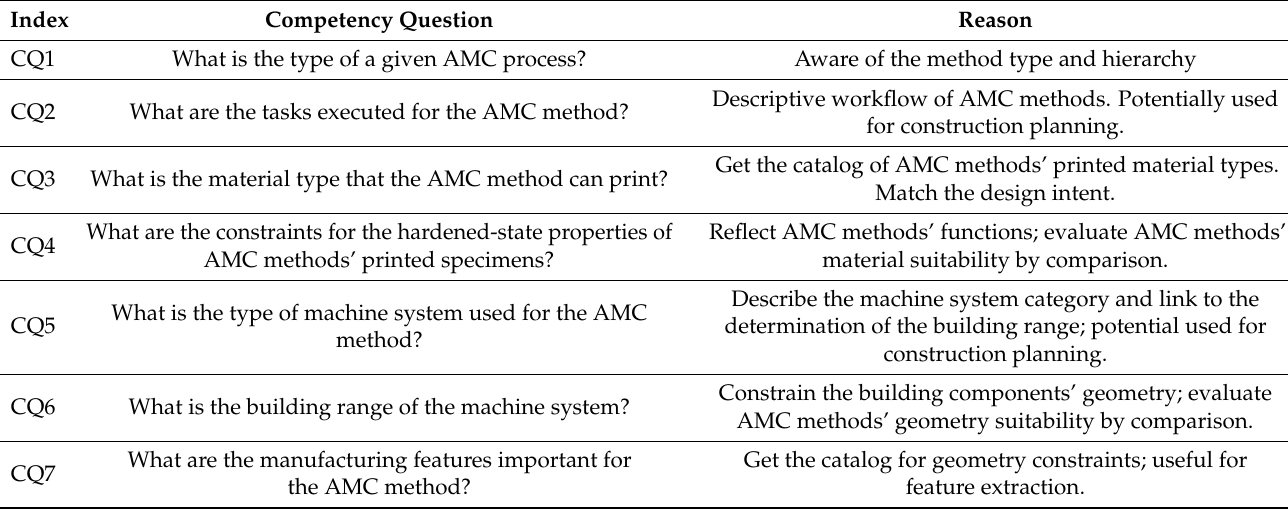
Table 1. Competency questions for AMC ontology.